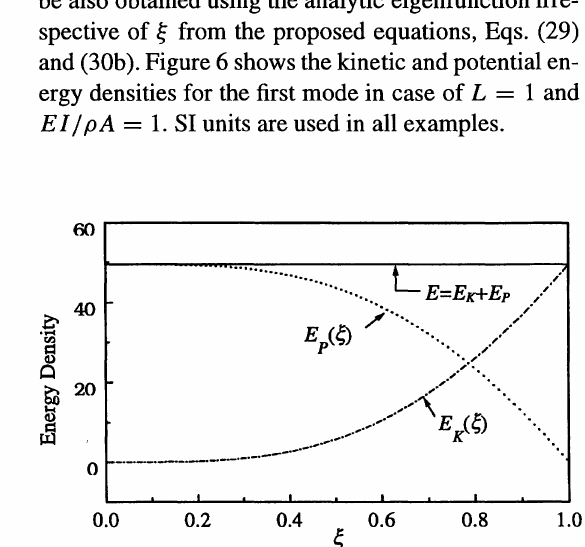
FIGURE 6 Energy densities of a cantilevered